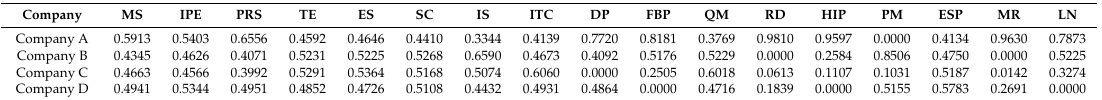
Table 5. Normalization of evaluation IAMSs decision matrix.